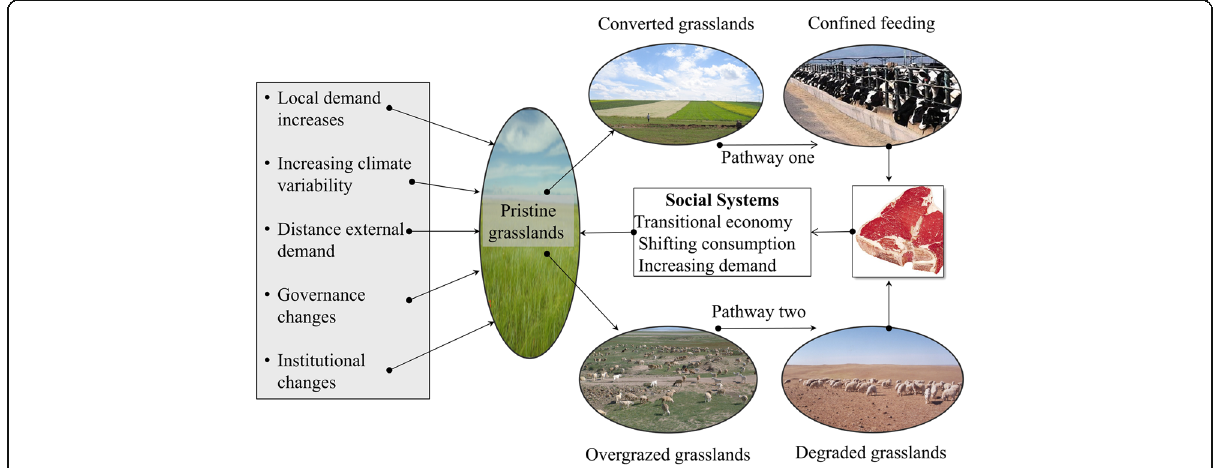
Fig. 2 A transition theory of grassland food production systems for the Asian Dryland Belt (ADB). Pressures to produce more livestock products result in either a pathway to grazing intensification and subsequently land degradation or conversion of grasslands to cropping systems for feedstocks to the livestock, or a combination of the